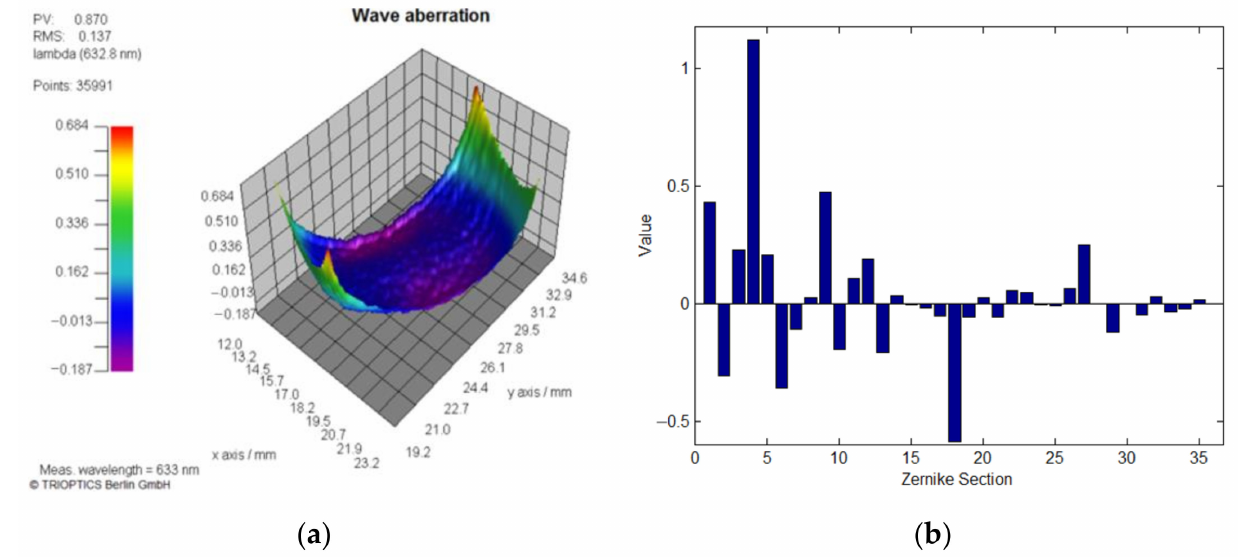
Figure 1. ( a ) The inherent WFD of LCoS-SLM and ( b ) its 36 Zernike coefficients